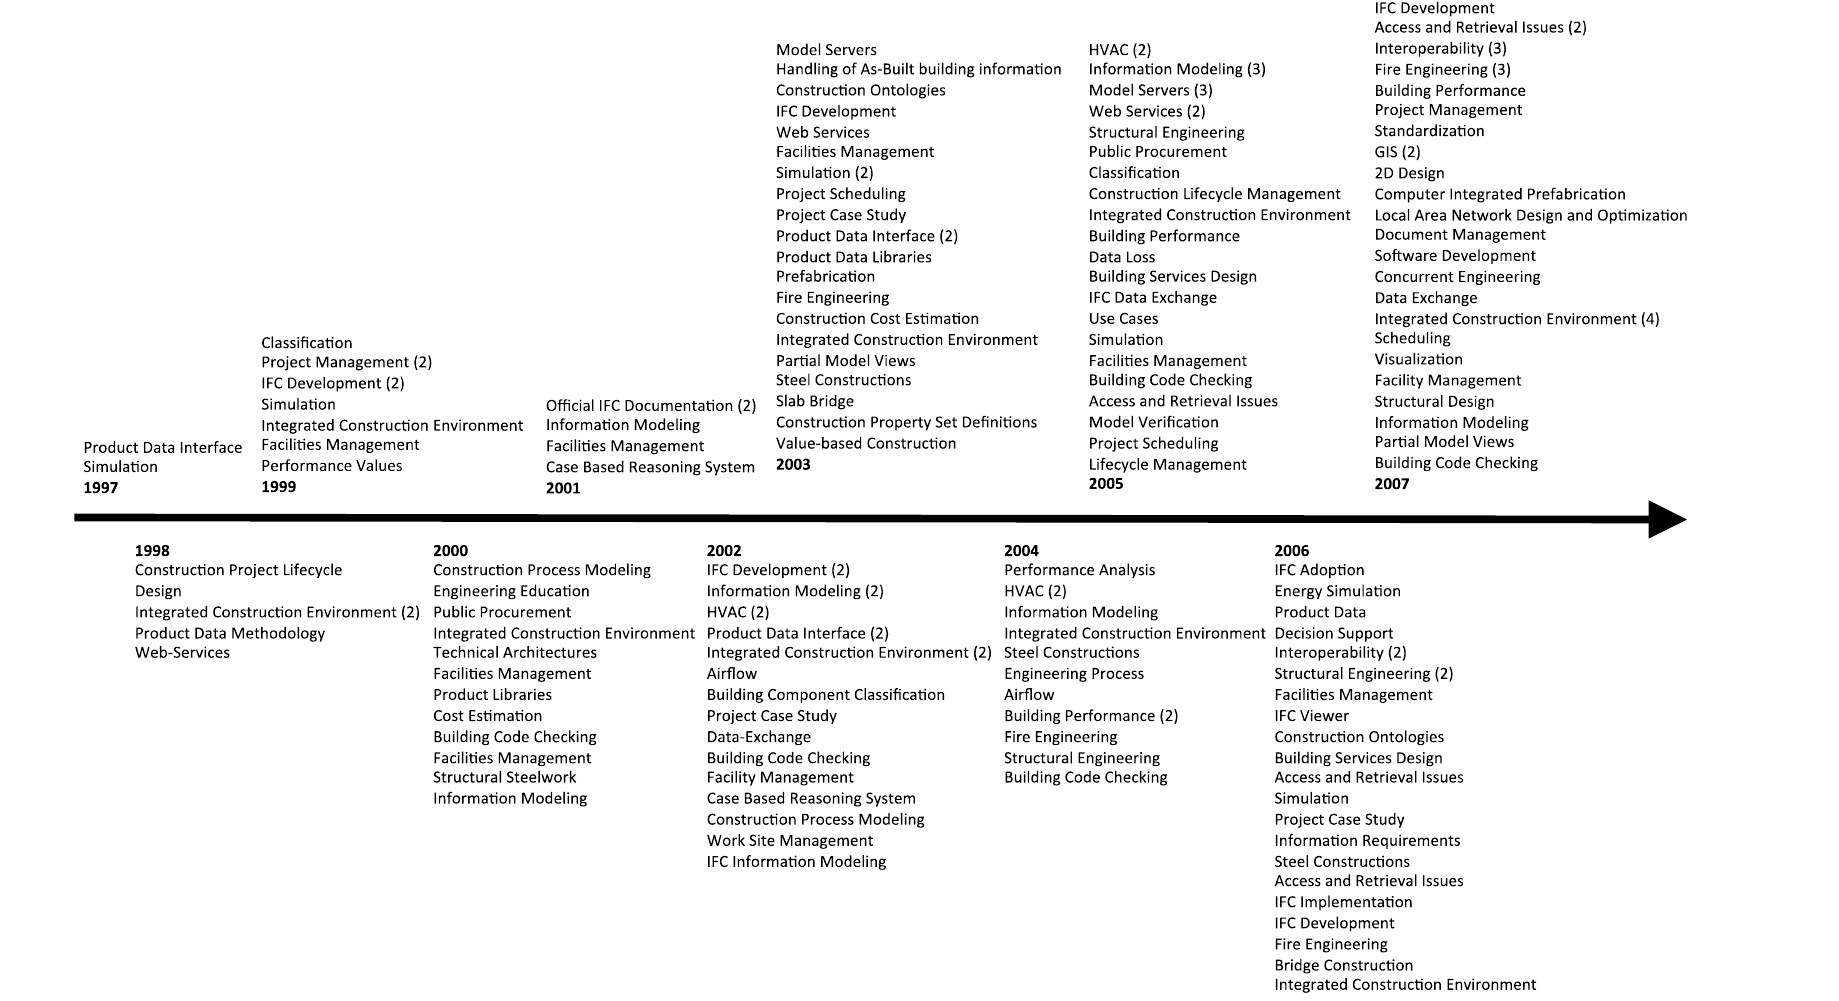
Figure 2. Primary construction domain or research context of each included publication.